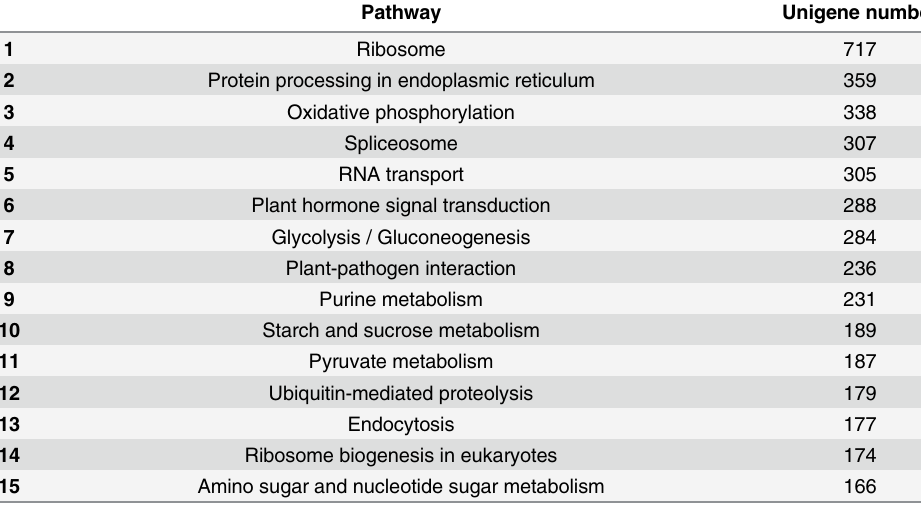
Table 4. The top 15 pathways in Artemisia sphaerocephala